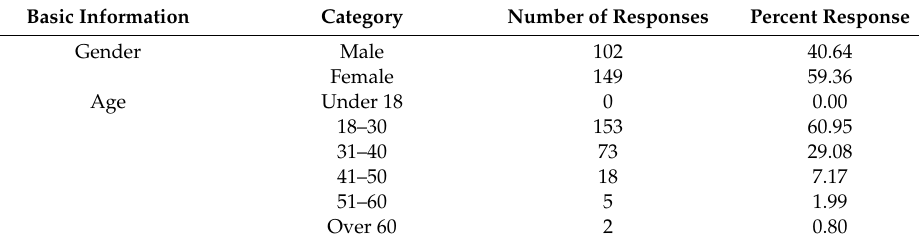
Table 2. Demographic profile of questionnaire respondents (n =